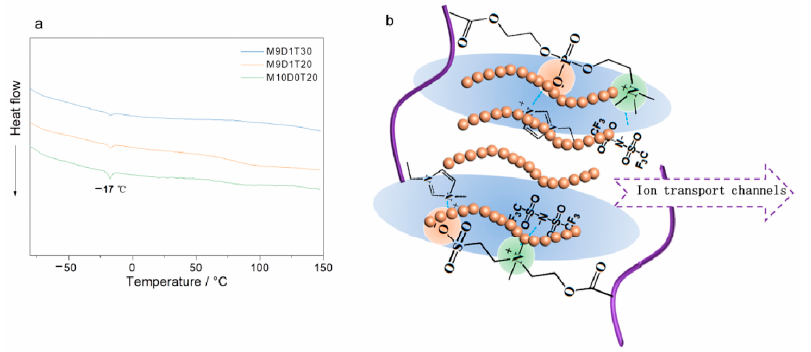
Figure 4. ( a ) DSC curves of double-network PEs with different ratios of TEOS and zwitterions. ( b ) Ion transport model of the prepared double-network PE.